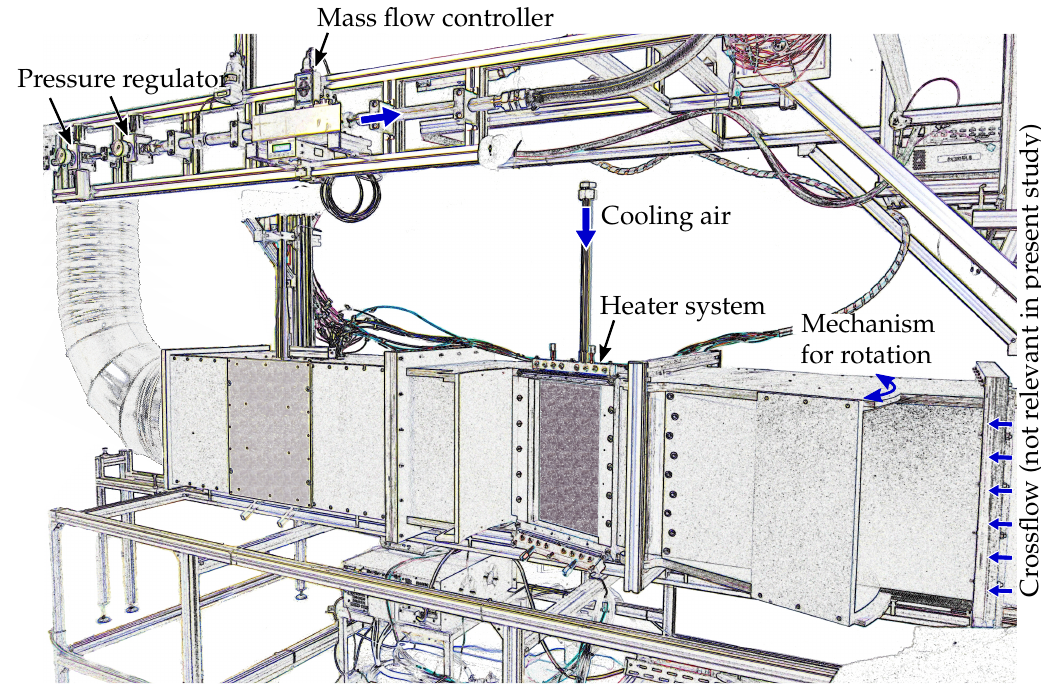
Figure 3. Experimental